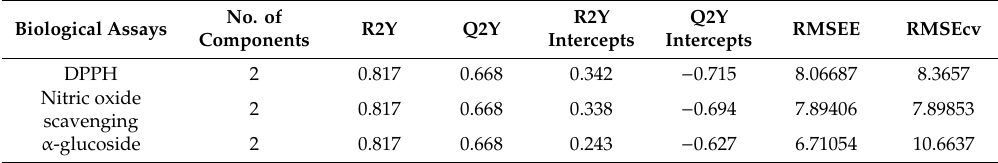
Table 3. PLS model